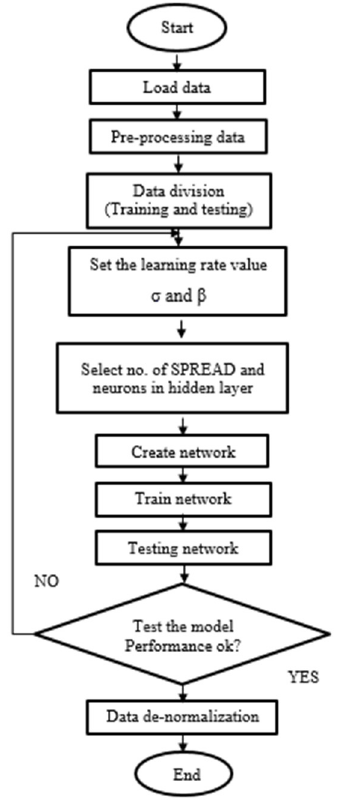
Figure 7. RBFNN procedure.